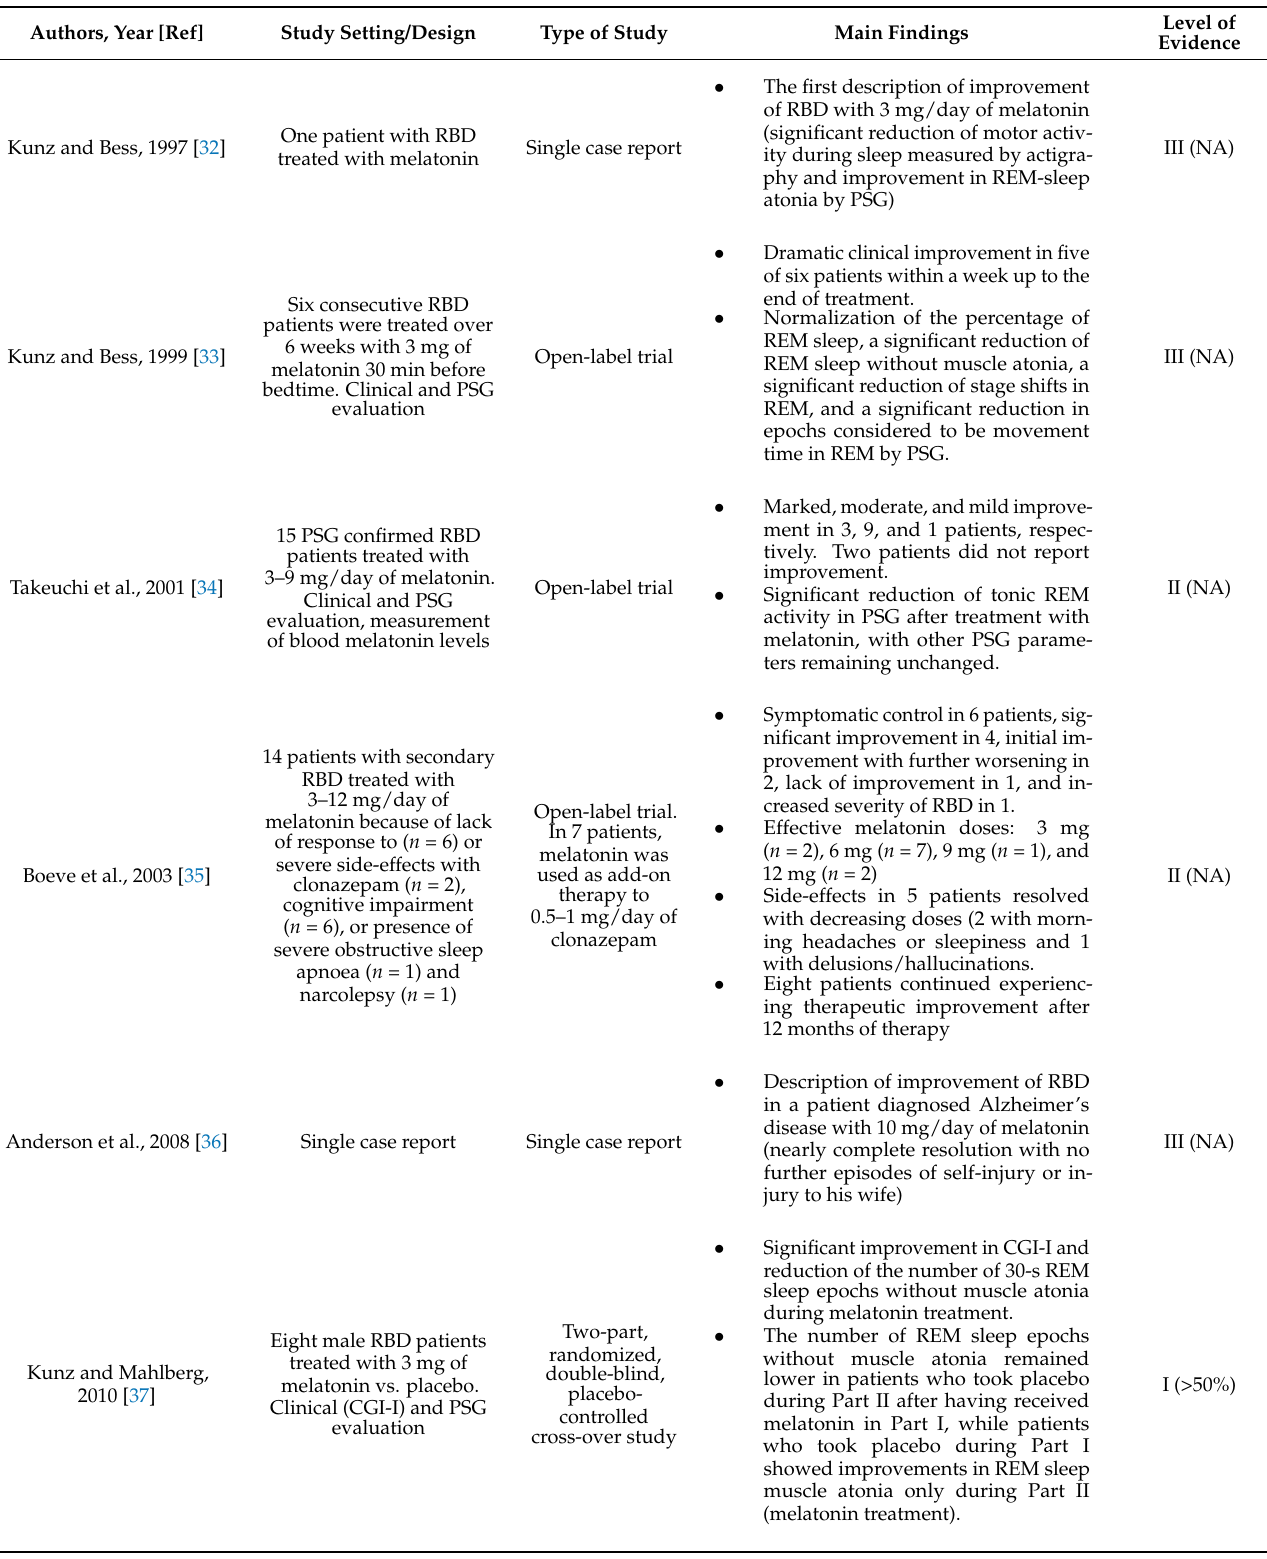
Table 2. Studies describing effects of melatonin in patients with